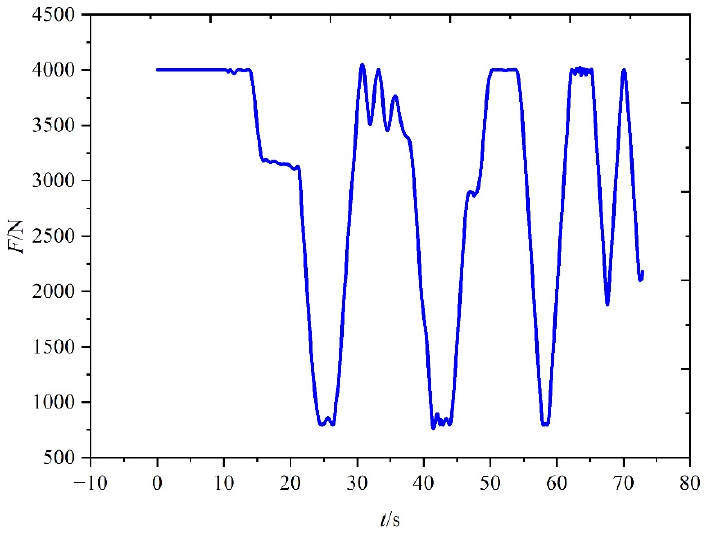
Figure 19. Thrust under case 2 in the third scenario vs. time.